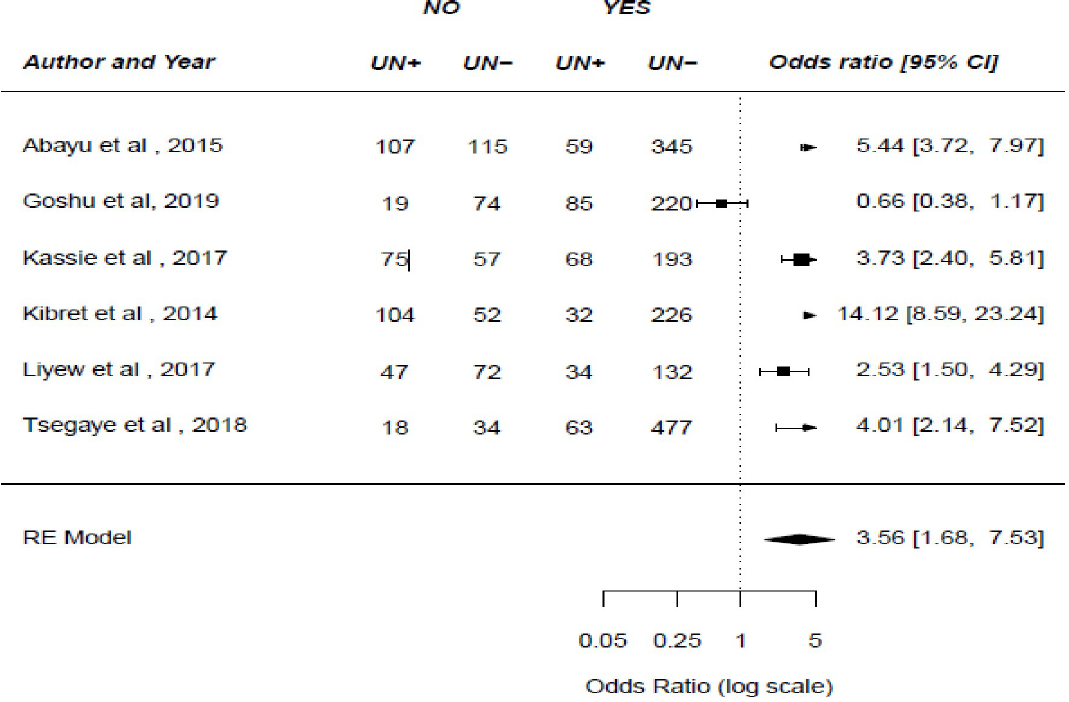
Fig 4. The pooled odds ratio of the association between spousal communication about family planning and unintended pregnancy in Ethiopia.